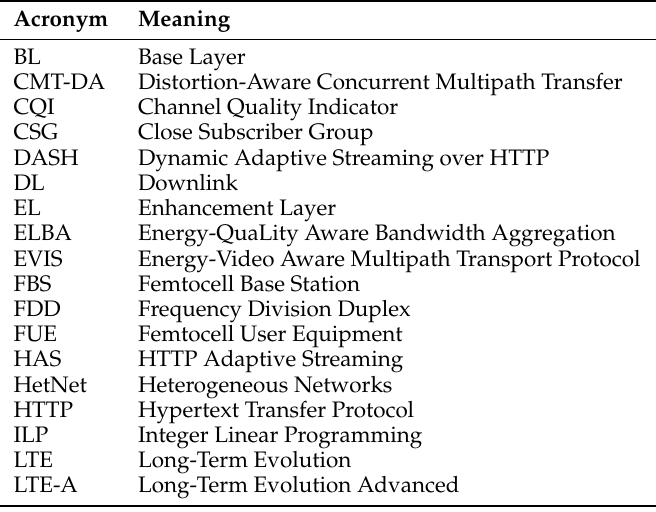
Table 1. Table of